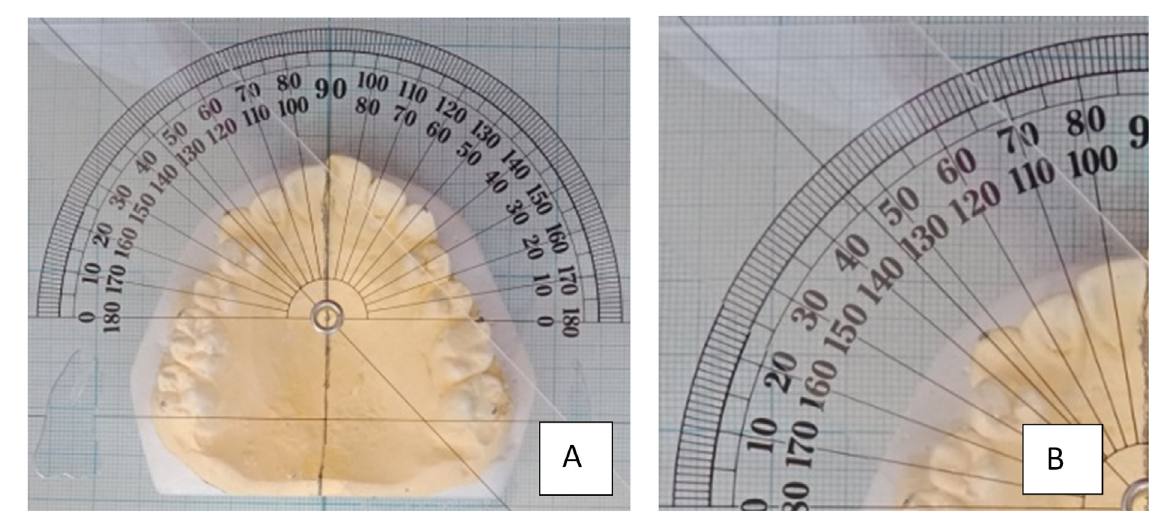
Figure 1. Measuring angular upper arch asymmetry. The plaster cast model is positioned with a protractor at the cusp of the right upper arch canine ( A ); the protractor shows that PC of right upper arch canine is 46°±1° ( B